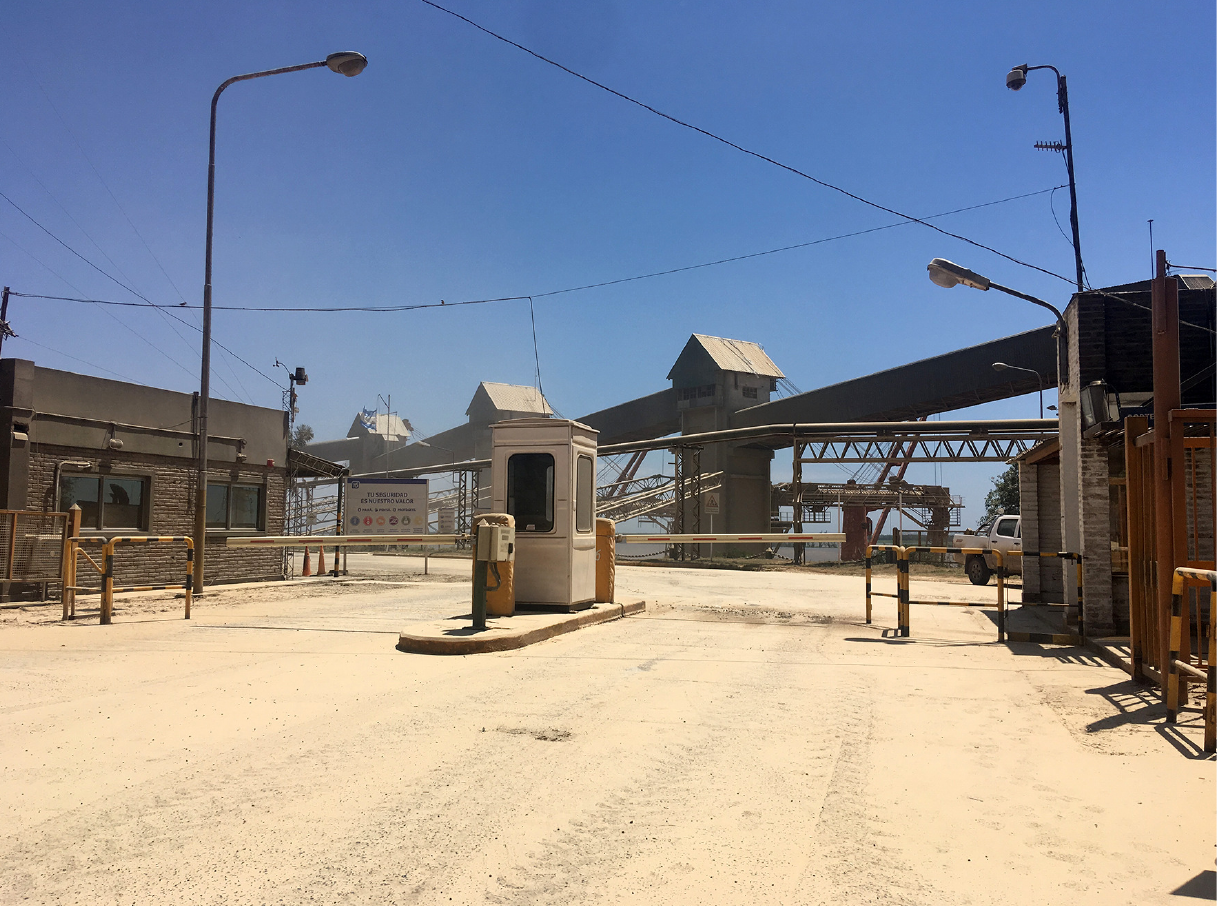
Figure 8. Entrance of a port in northern Gran Rosario, covered in grain dust